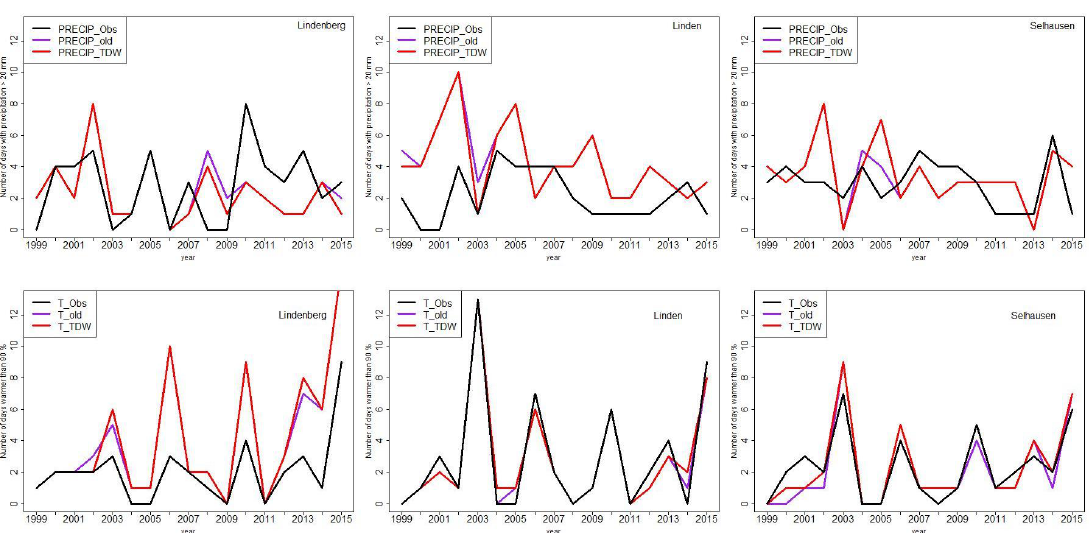
Figure 7. Heavy precipitation events with more than 20mm per day ( top ) and very warm days within the 90th Percentile of the observed maximum temperatures ( bottom ) in each year of the period 1999 to 2015 at Lindenberg, Linden and Selhausen for the HYRAS observations (_Obs, –), the simulations with the standard phenology (_old, –) and the simulations with the new phenology (_TDW,